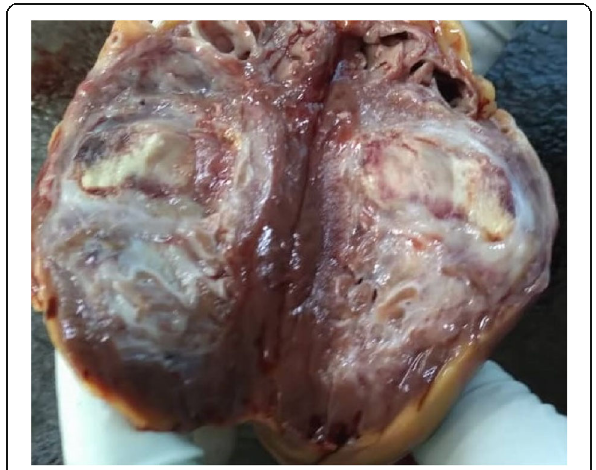
Fig. 1 Gross photograph of the tumour. The tumour is white-tan, well circumscribed